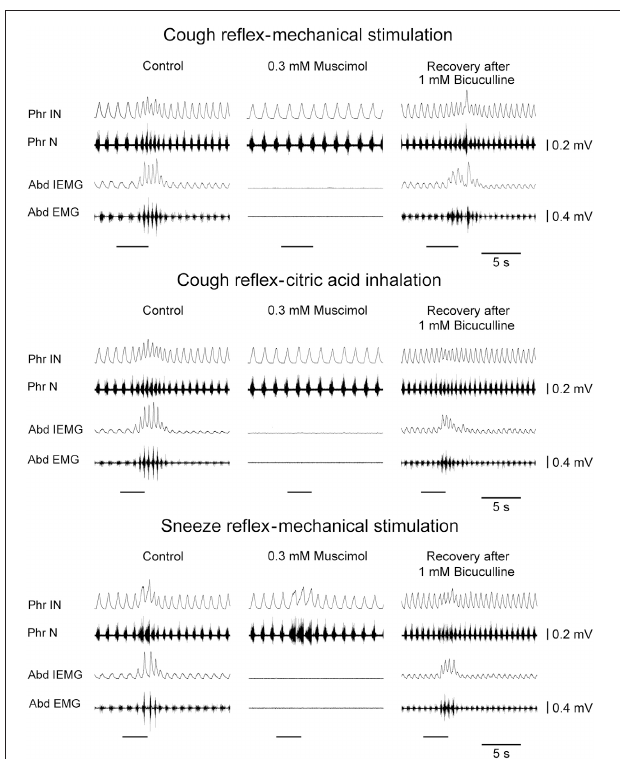
FIGURE 3 | Depressant effects on the cough reflex and on the sneeze reflex ∼ 20min following bilateral microinjections of muscimol into the cVRG of one anesthetized spontaneously breathing rabbit. The recovery of reflex responses ∼ 5min after 1mM bicuculline microinjections is reported. Stimulation periods marked by filled bars. Phr IN, phrenic integrated neurogram; Phr N, phrenic neurogram; Abd IEMG, abdominal integrated electromyographic activity; Abd EMG, abdominal electromyographic